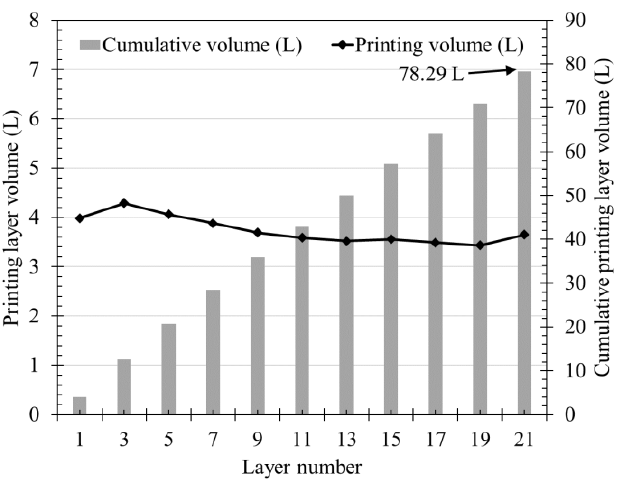
Figure 13. Volume of printed layer per cycle and cumulative printed layer volume.